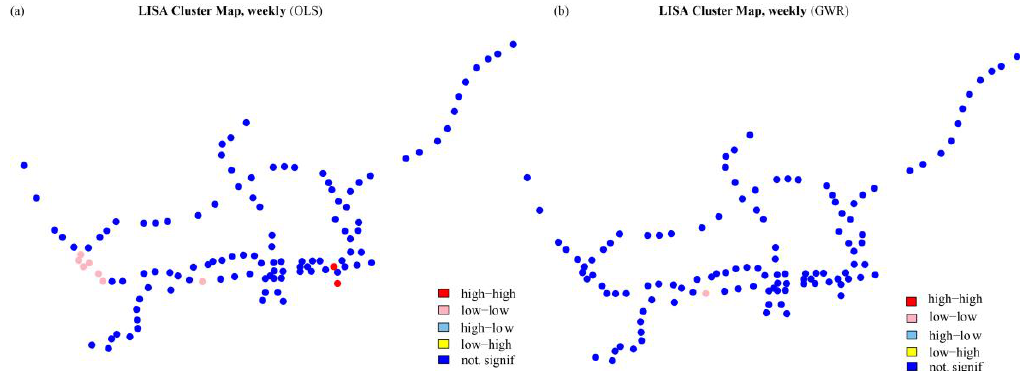
Figure 5. Local indicator of spatial association (LISA) cluster maps of residuals in the OLS and GWR models. Colors indicate significant positive (red and pink), negative (pale blue and yellow), and not significant (blue) spatial autocorrelation. (a) LISA cluster map of residuals of OLS model for the average ridership across the whole week. (b) LISA cluster map of residuals of GWR model for the average ridership across the whole week. Table 6. Global Moran’s I residuals test of the models for the average ridership across the whole